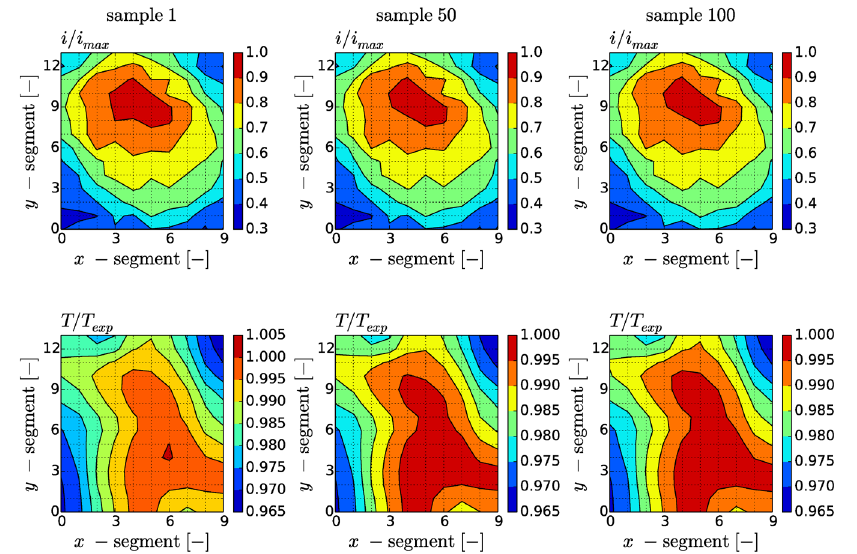
Fig. A2. Distribution of the current density and temperature at maximal load in the AST -